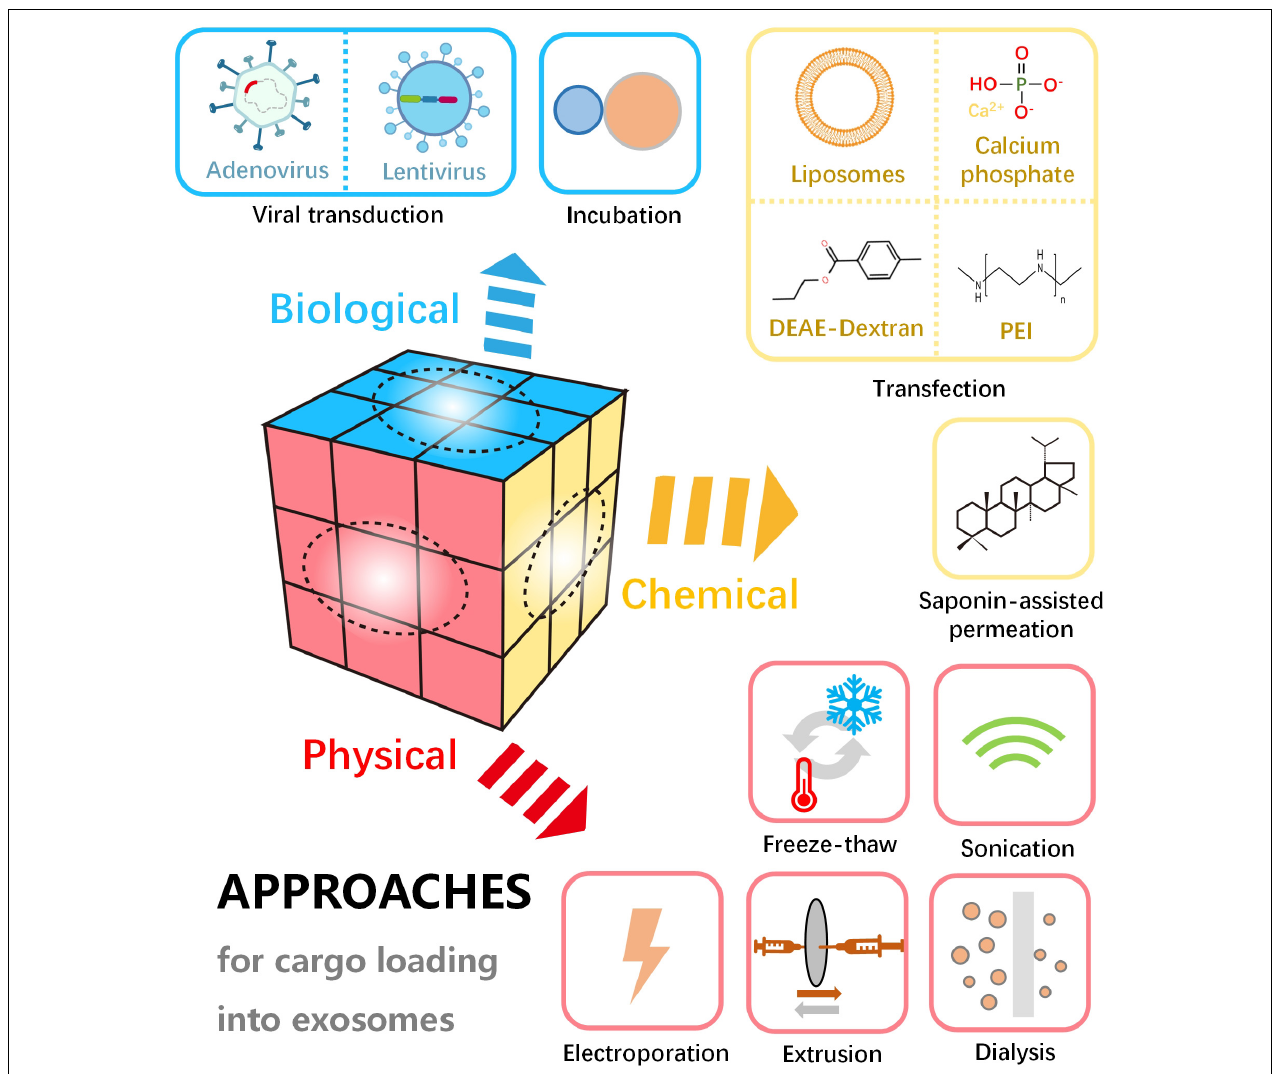
FIGURE 4 | Schematic diagram of various approaches for cargo loading into or onto exosomes, including physical, chemical, and biological